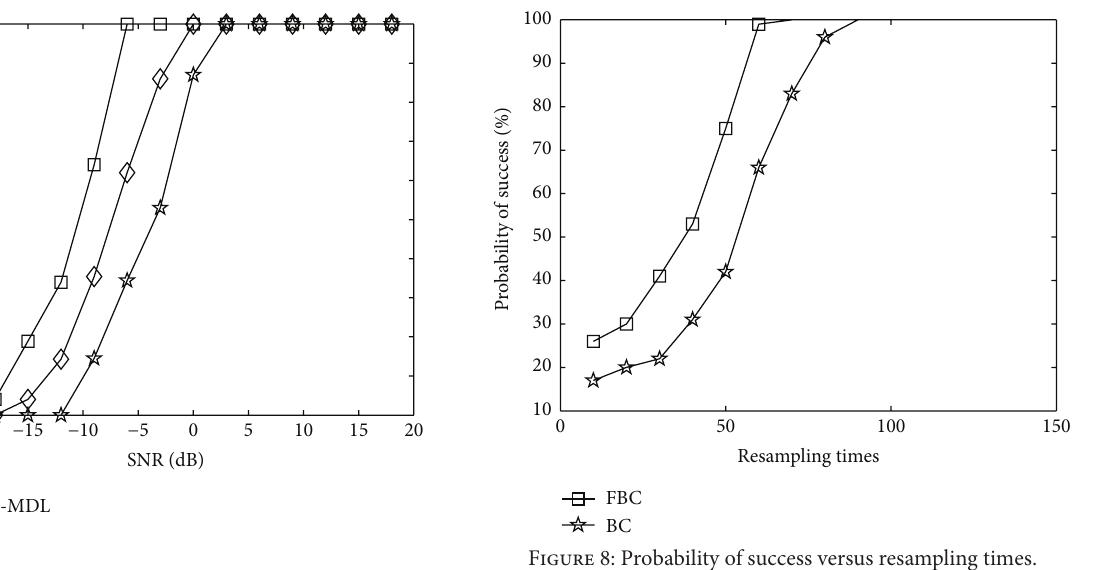
Figure 6: Probability of success versus SNR for coherent signals.